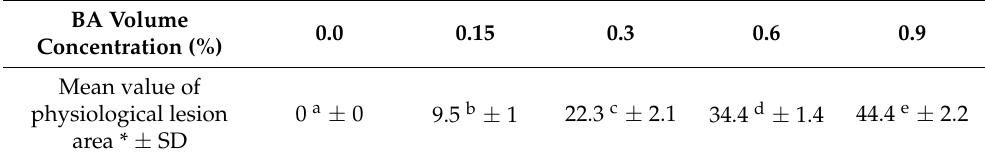
Table 1. Effect of BA on tomato plants, 14 days after application.